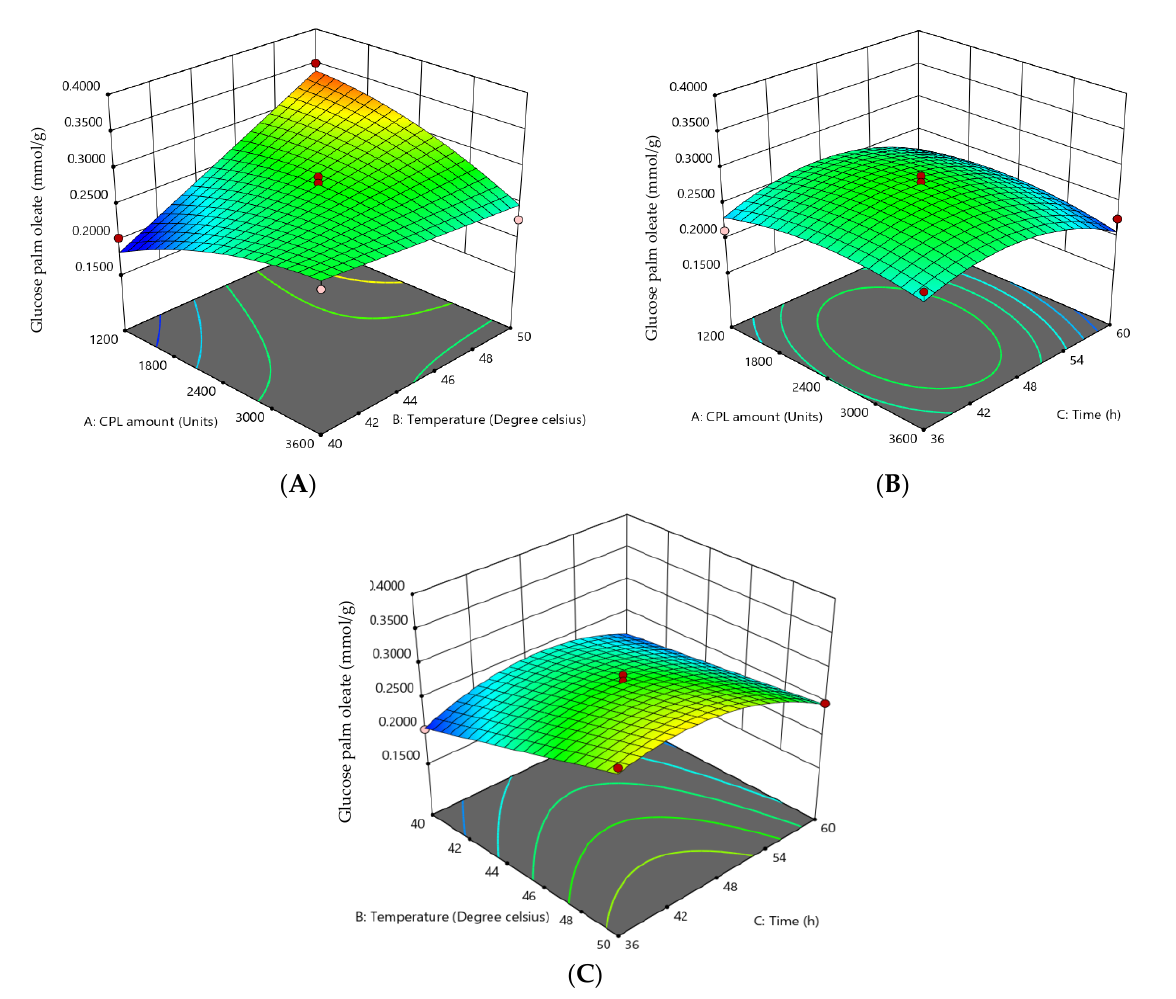
Figure 2. Graphical interpretation of the model describing the dependence of glucose palm oleate content on ( A ) CPL amount and temperature, ( B ) CPL amount and reaction time, and ( C ) temperature and reaction time. The RSM revealed the optimum condition for green synthesis of glucose palm oleate of 50 °C, 45 h reaction time, and 1400 U of CPL.